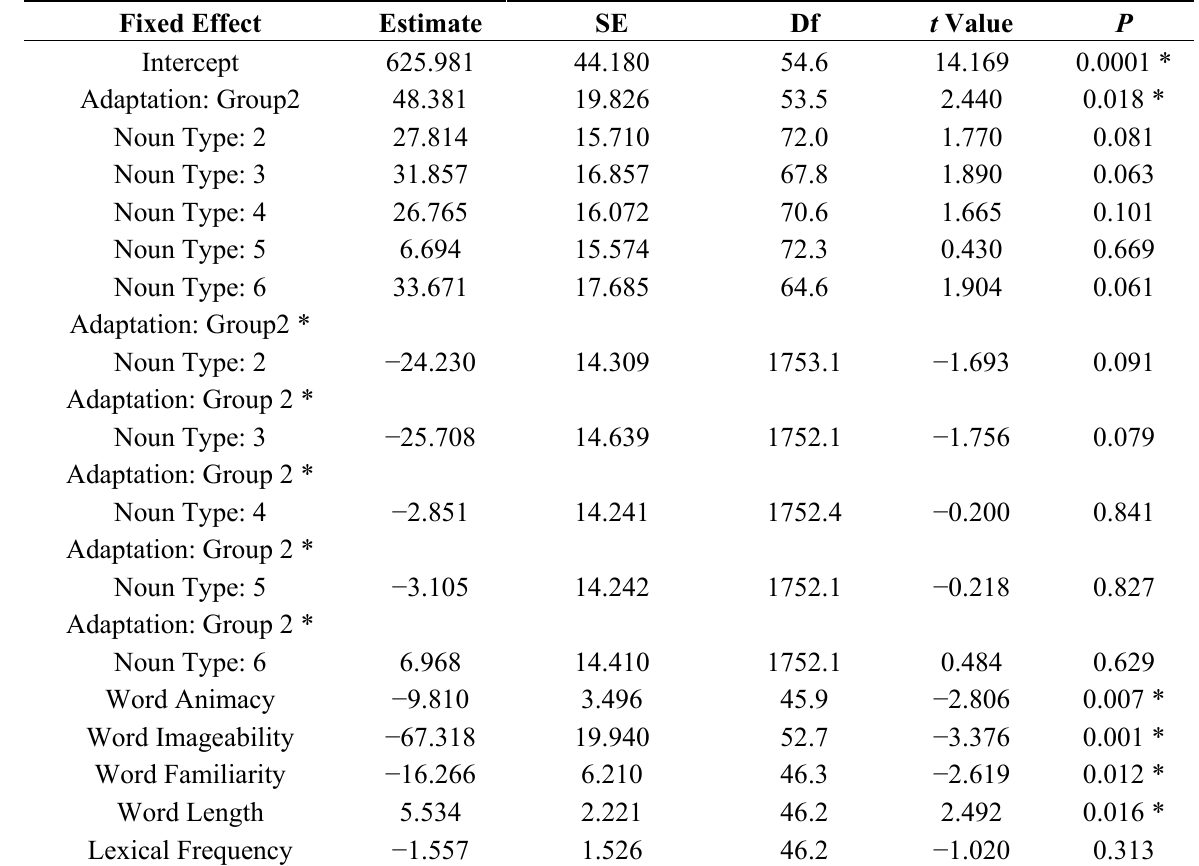
Figure 3. Regression lines (bold black lines) showing the effect of adaptation induced in participants of Group 1 ( left panel) and Group 2 ( right panel) on reaction times. Colored thick lines show the effect also for each participant. Table 2. Fixed effect of the final mixed model on noun categorization